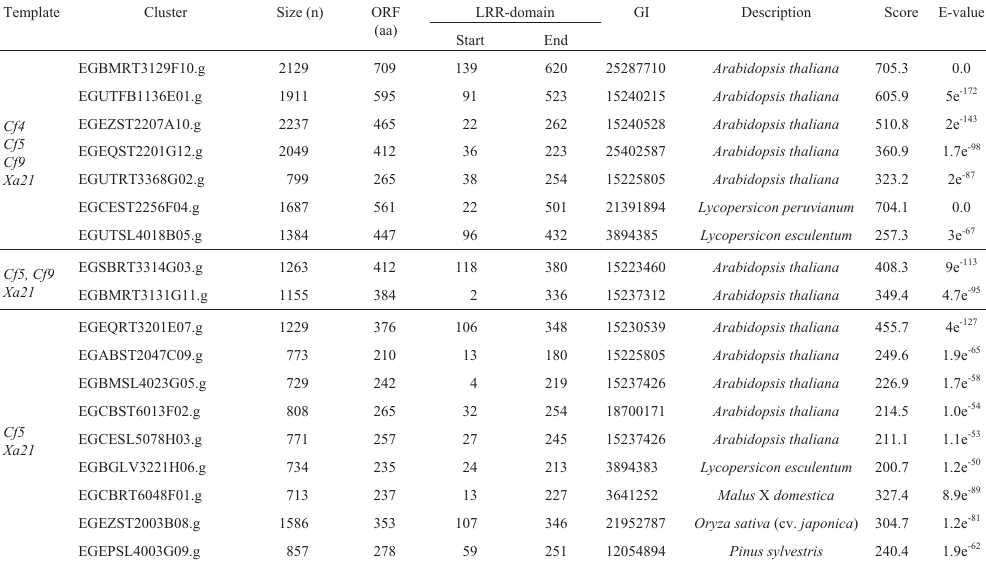
Table 3 - FOREST clusters classified in the MIX I group, resembling to genes which belong to LRR and LRR-KINASE classes, including: respective templates (query sequences), cluster number and size in nucleotides (n), ORF-size in amino-acids (aa), range of LRR domain after CD-search, identity and results of the best alignment (BLASTp) in NCBI (GI number, species, score and e-value).